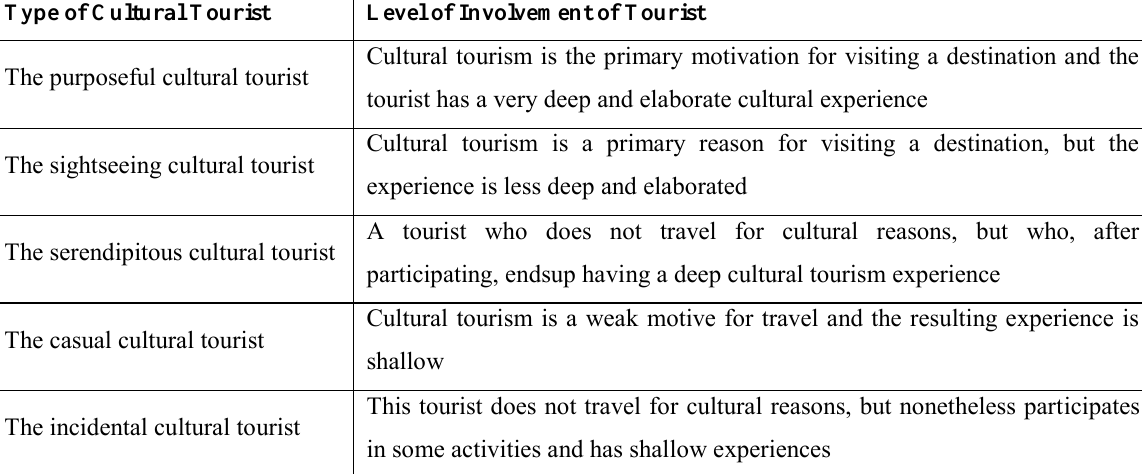
Table 1: Type of Cultural Tourism and Level of involvement of Tourists